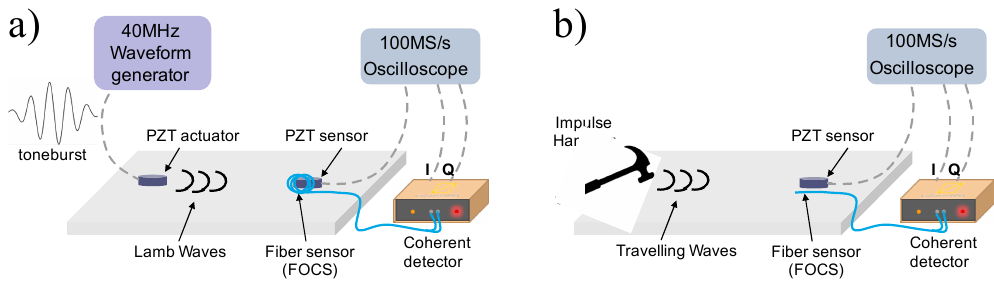
Figure 3. Test layout for ( a ) active and ( b ) passive impact monitoring cases. FOCS: fiber optic coherent sensor. PZT: piezoelectric.